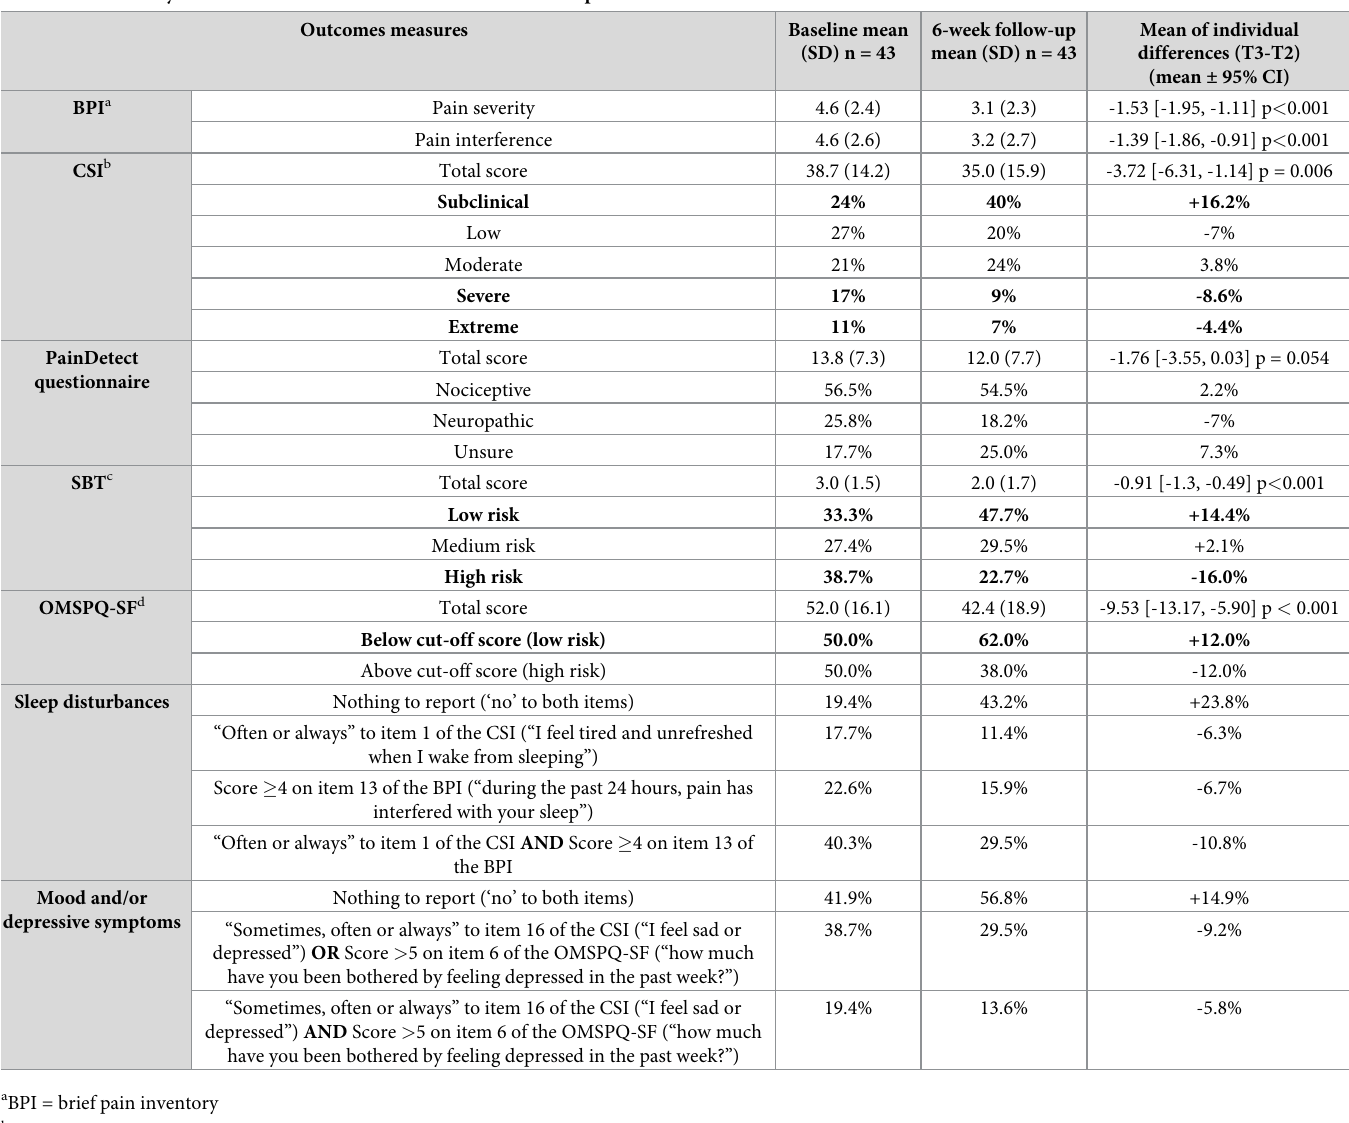
Table 6. Preliminary effect outcome measures at baseline and